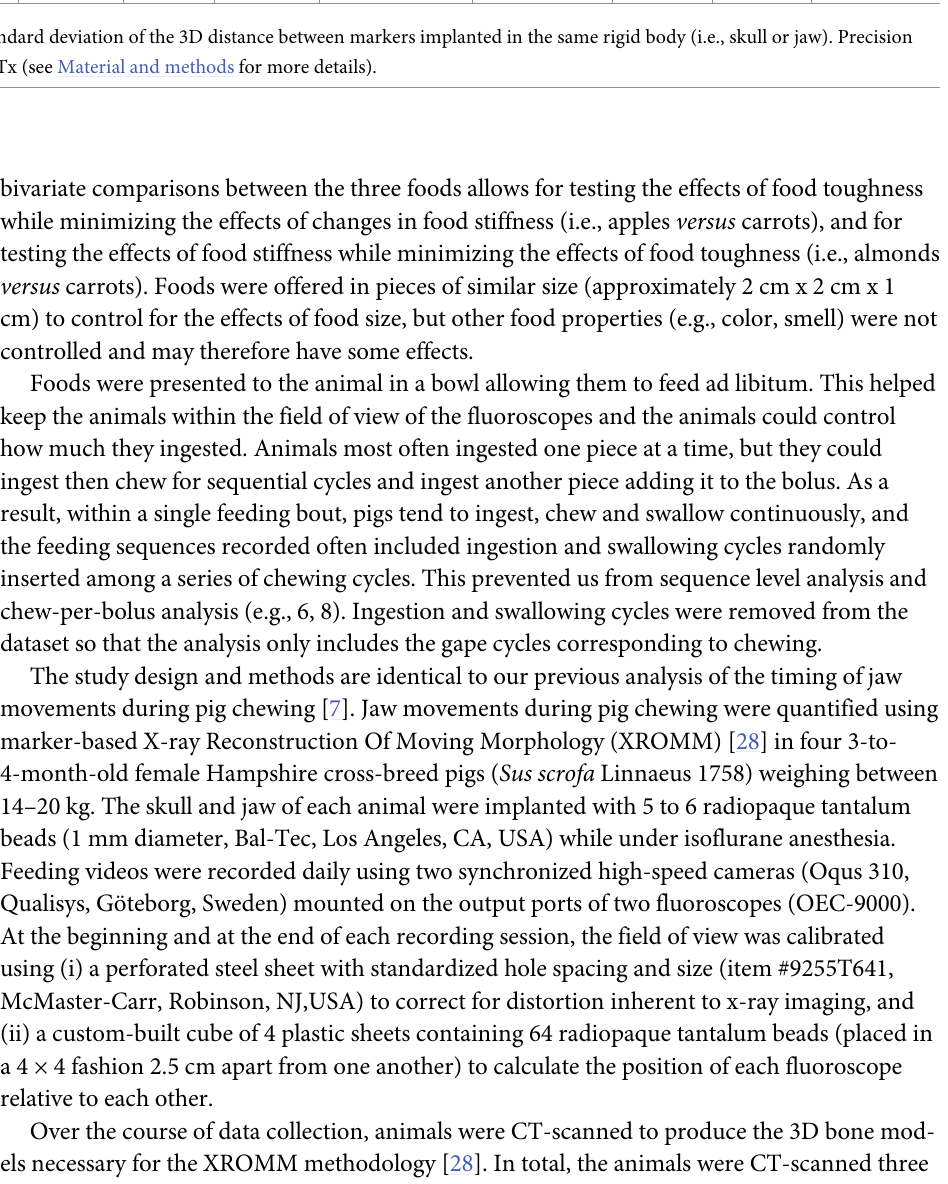
Measurement error is quantified by the average standard deviation of the 3D distance between markers implanted in the same rigid body (i.e., skull or jaw). Precision thresholds for movement detection for Ry, Rz and Tx (see Material and methods for more